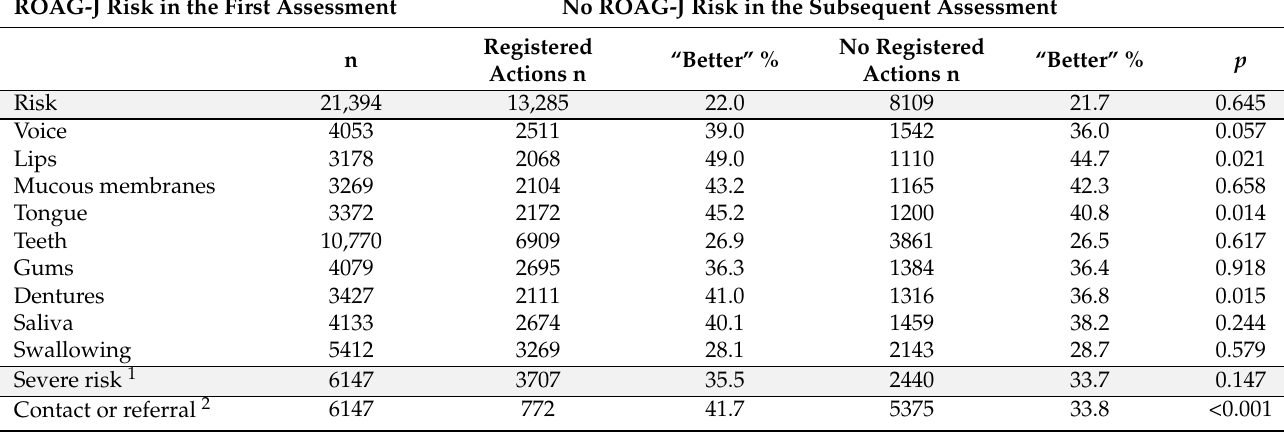
1 . Individuals assessed having “severe risk” (grade 3); any of the eight preventive actions can have been registered. 2 . Individuals assessed having “severe risk” (grade 3) and the action “Contact or referral with dentist/physician, when a grade 3 is registered” having been